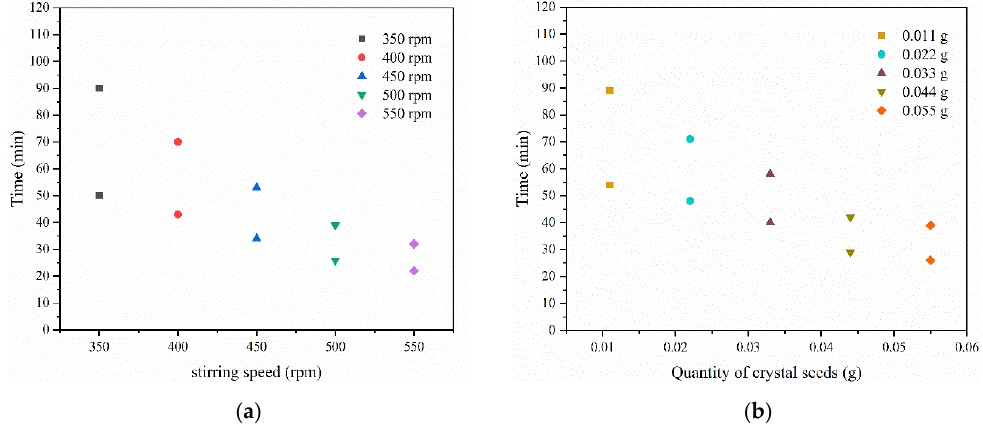
Figure 15. The induction time and transformation time of the co-crystallization by ( a ) different stirrer speed and ( b ) different quality of crystal seeds, respectively.